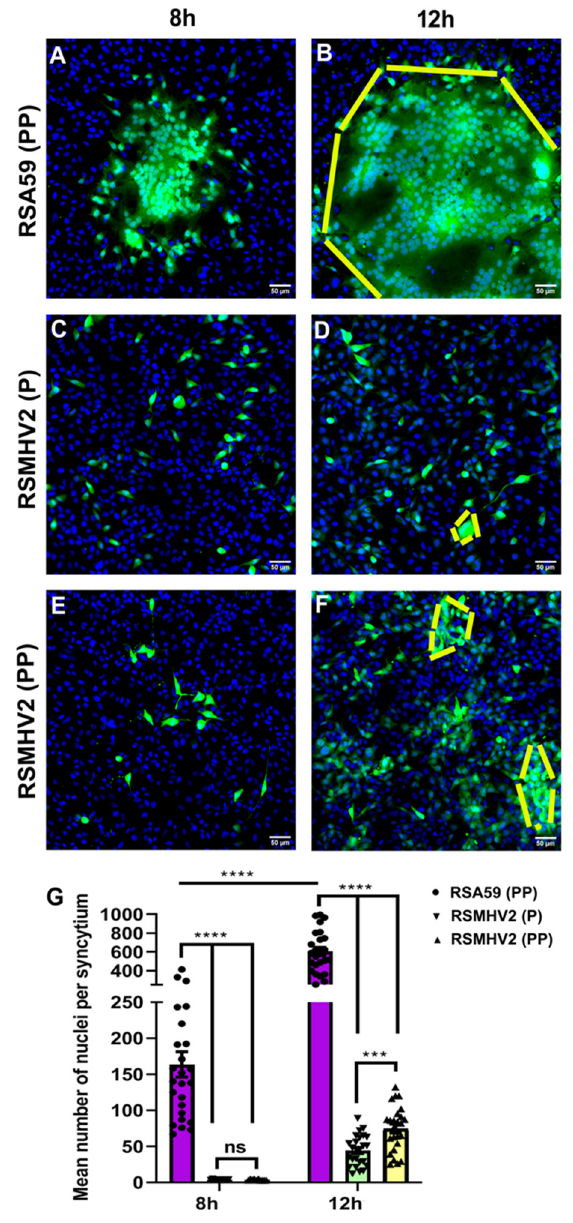
Figure 4. Effect of double proline on the fusogenic ability of RSA59 (PP), RSMHV2 (P), and RSMHV2 (PP) in DBT cell line . DBT cells were infected with RSA59 (PP), RSMHV2 (P), and RSMHV2 (PP) at an MOI of 0.5. Viral Antigen is denoted by EGFP fluorescence. Images are composite of DAPI and FITC channels; Panel ( A , B ) are from RSA59 (PP) infected DBT cells at 8 h and 12 h p.i, respectively. Large syncytia are indicated within the dashed lines. Panel ( C , D ) and ( E , F ) depicts DBT cells infected by RSMHV2 (P) and RSMHV2 (PP), respectively at 8 h and 12 h p.i. Dashed lines indicate clusters of infected cells in panels ( D , F ). The mean nuclei per syncytium in panels ( A , B ), and clusters of infected cells in panels ( C – F ) were counted and plotted in the scatter-bar diagram ( G ). Experiments were repeated three times (N = 3) with three replicates per experiment per virus